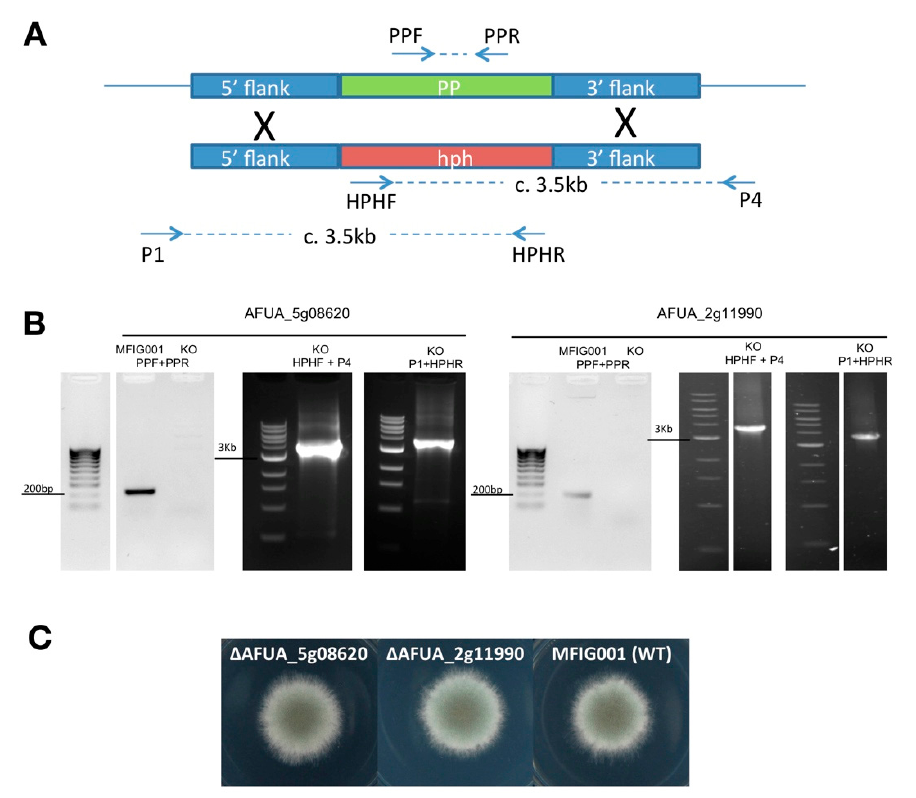
Figure 1. Protein phosphatase gene disruption. ( A ) Schematic representation of protein phosphatase (PP) gene replacement with a hygromycin-selectable marker (hph). The position of oligonucleotide primers used for validation in panel B, are given as arrows with indicative sizes of PCR amplicons shown between (sequences are listed in Supplementary Table S2). ( B ) PCR validation of the AFUA_5g08620 and AFUA_2g11990 null mutants. ( C ) Phenotype of the isogenic wild-type MFIG001 alongside the AFUA_5g08620 and AFUA_2g11990 null mutants on Aspergillus minimal media (48 h).